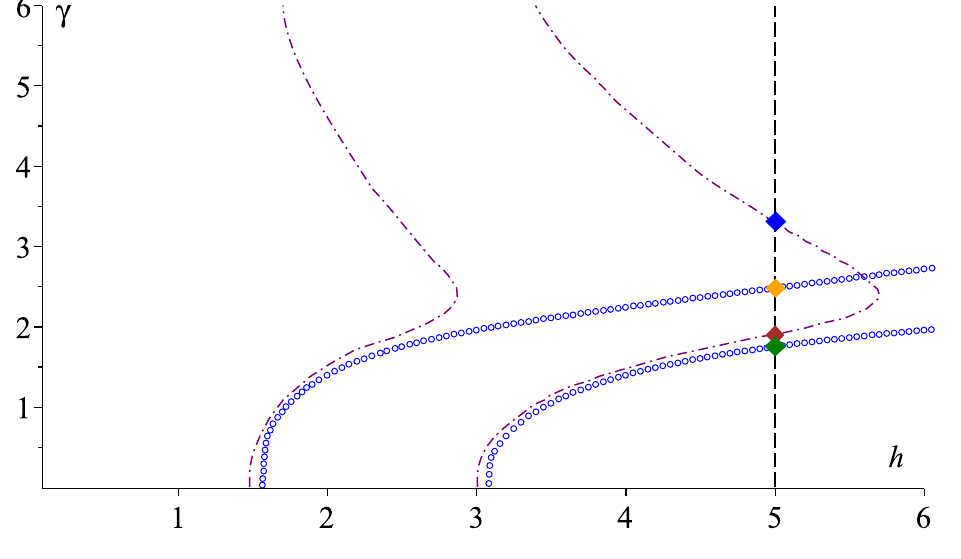
Figure 5. Dispersion curves of problems